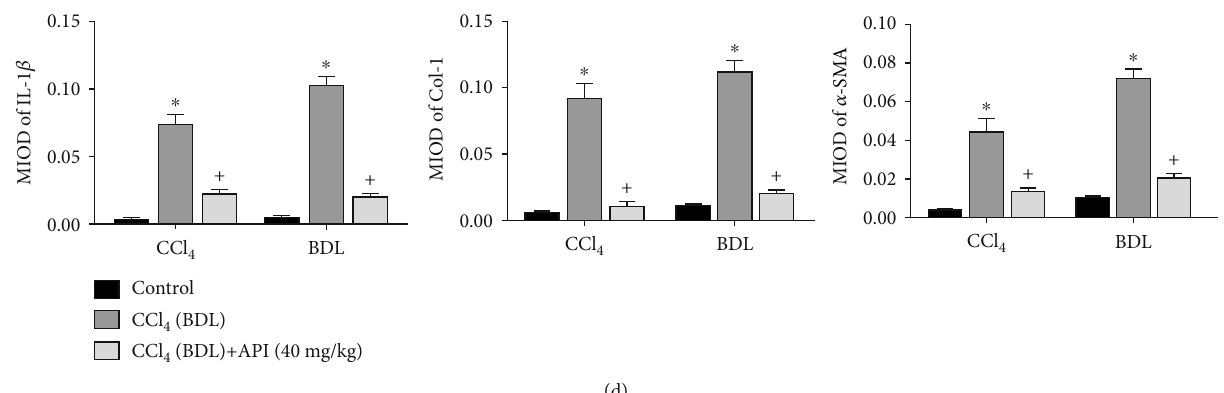
Figure 3: Apigenin restrained the activation of HSC and regulated the balance of TIMP1 and MMP2. Notes: (a) relative IL-1 β , Col-1, α -SMA, TIMP1, and MMP2 mRNA levels were determined by qRT-PCR. (b) Western blot analysis of IL-1 β , Col-1, α -SMA, TIMP1, and MMP2 protein levels. (c) IL-1 β , Col-1, and α -SMA protein expressions in liver tissues are shown by immunohistochemical staining (200x). (d) Final evaluations were made using Image-Pro Plus 6.0 software to calculate the MIOD of the positive staining area. Data are presented as mean ± SD ( n = 6 ; ∗ P < 0 : 05 for CCl (BDL) group vs. control group; # P < 0 : 05 for CCl (BDL)+apigenin (20 mg/kg) group vs. CCl (BDL) 4 4 4 group; + P < 0 : 05 for CCl (BDL)+apigenin (40 mg/kg) group vs. CCl (BDL) group; ! P < 0 : 05 for CCl (BDL)+apigenin (40 mg/kg) group 4 4 4 vs. CCl (BDL)+apigenin (20 mg/kg) group). Abbreviation: MIOD: mean of integrate optical 4